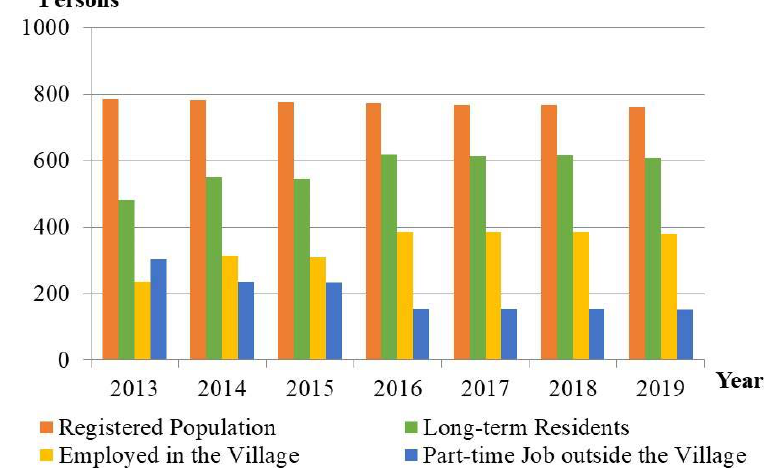
Figure 9. The change in population and employment in Baiyankeng village (2013–2019) (data provided by the village